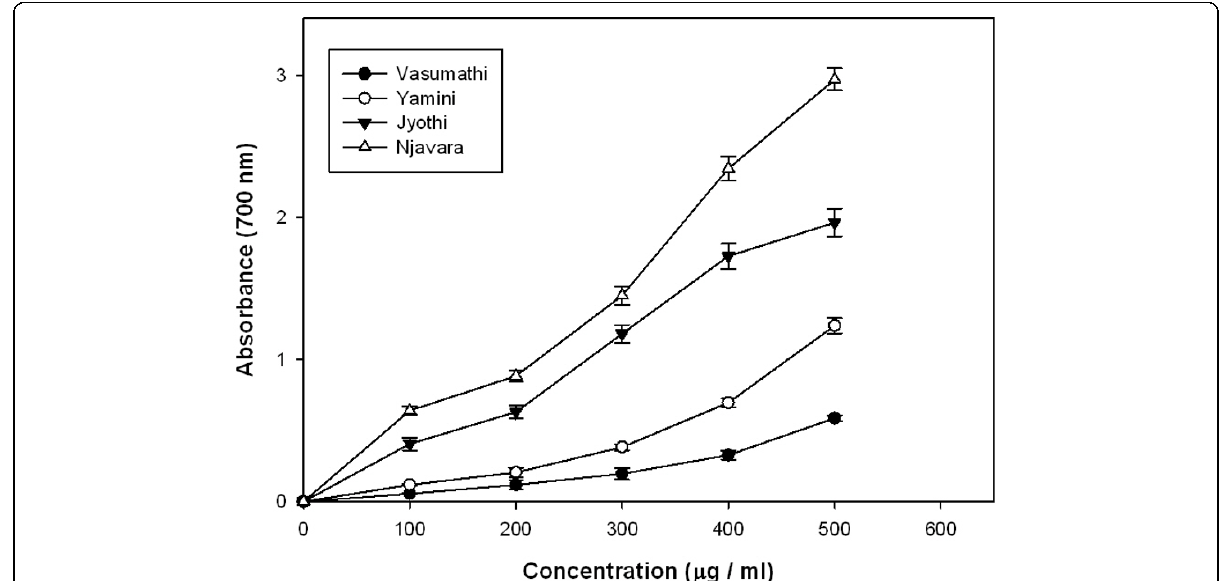
Figure 2 Reducing power . RP of different concentrations of methanolic rice bran extracts from four rice varieties. Results represent means ± standard deviation (n = 3).